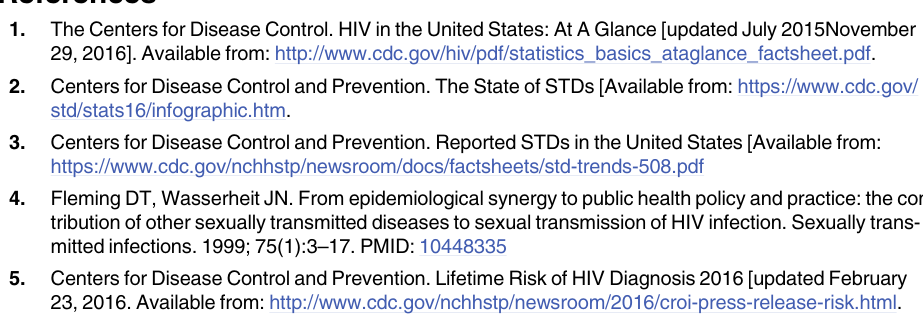
S1 Fig. Focus group script. S2 Fig. Focus group participant ages (years) according to